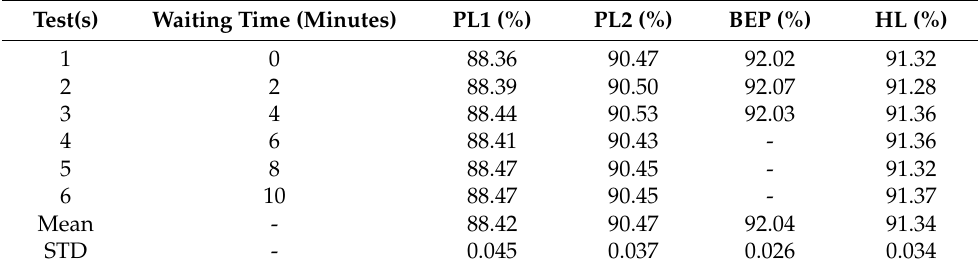
Table 4. Hydraulic efficiency (in %) details for different operating conditions.